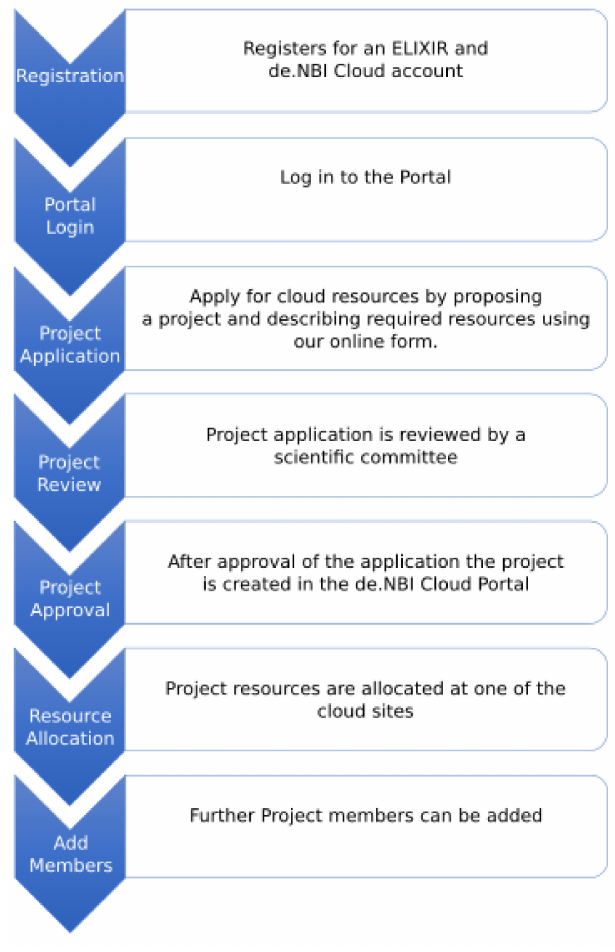
Figure 1. Project application process for de.NBI Cloud